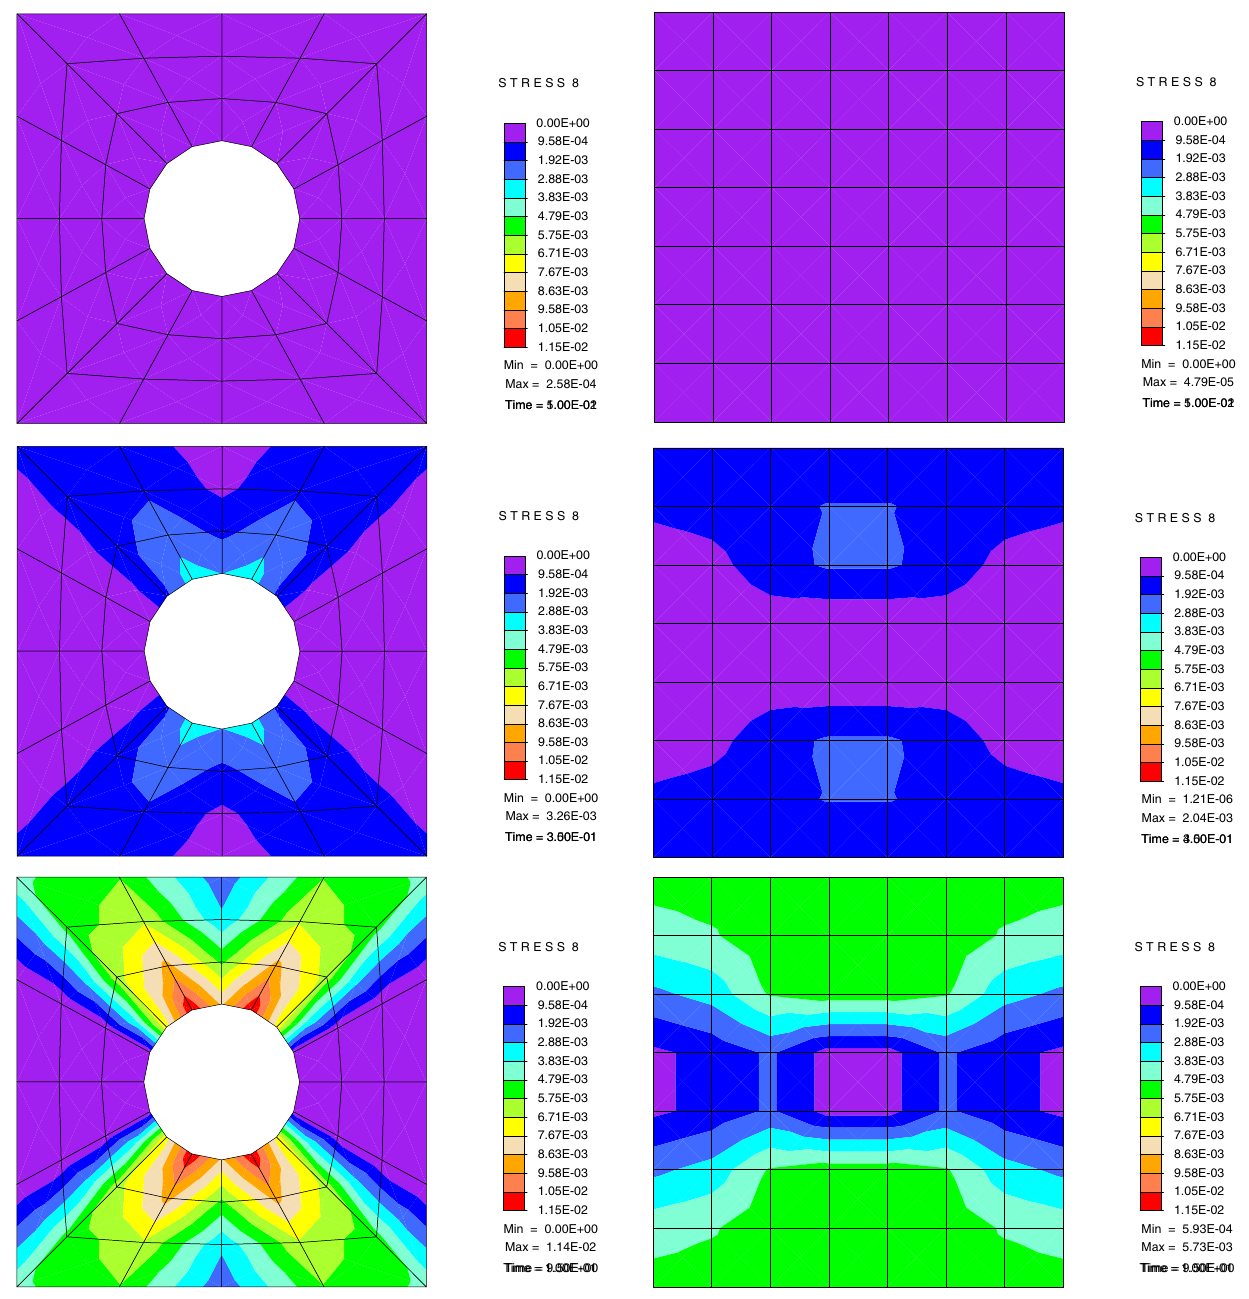
Fig. 5 Comparison of RVE computation results for coupled damage-plasticity: exact [41] versus structured [89] finite element mesh repre-